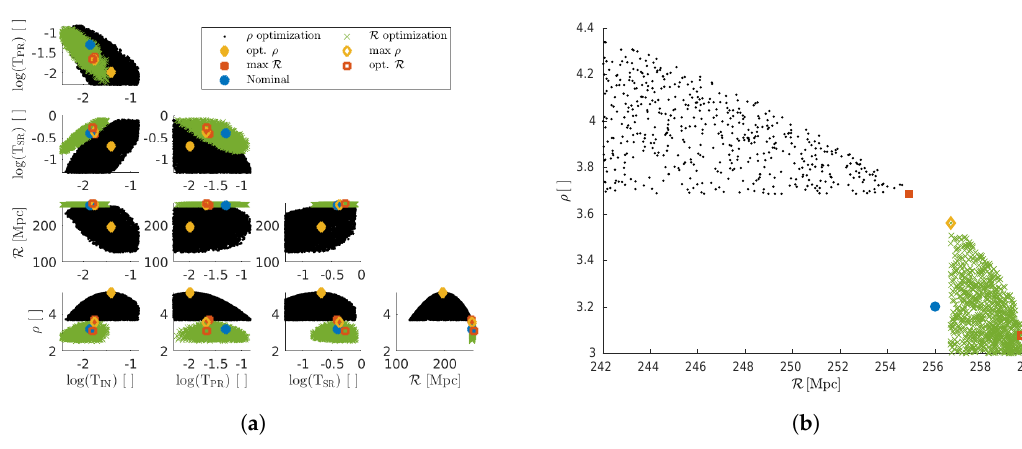
Figure 9. ( a ) Correlations found for 85ppm RTLs. R (green) uses 3Mpc budget and ρ (black) uses 1.5SNR budget. Color points indicate nominal configuration (blue), opt. R (open red), max ρ (open yellow), opt. ρ (solid yellow), and max R (solid red). ( b ) Enlargement of R and ρ plot (bottom right of corner plot).